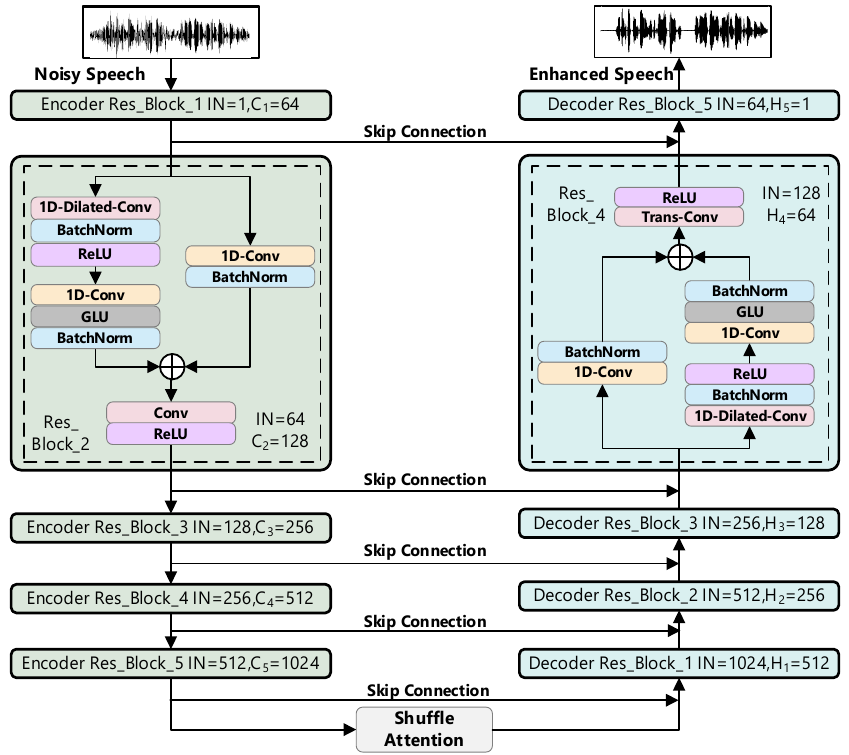
Figure 2. Proposed model architecture, with 5 coding layers, 5 decoding layers, and 1 Shuffle Attention. IN represents the channel of input speech feature map in each layer, C i and H i , respectively, represent the channel of speech feature map after down-sampling and up-sampling at the i-th layer.